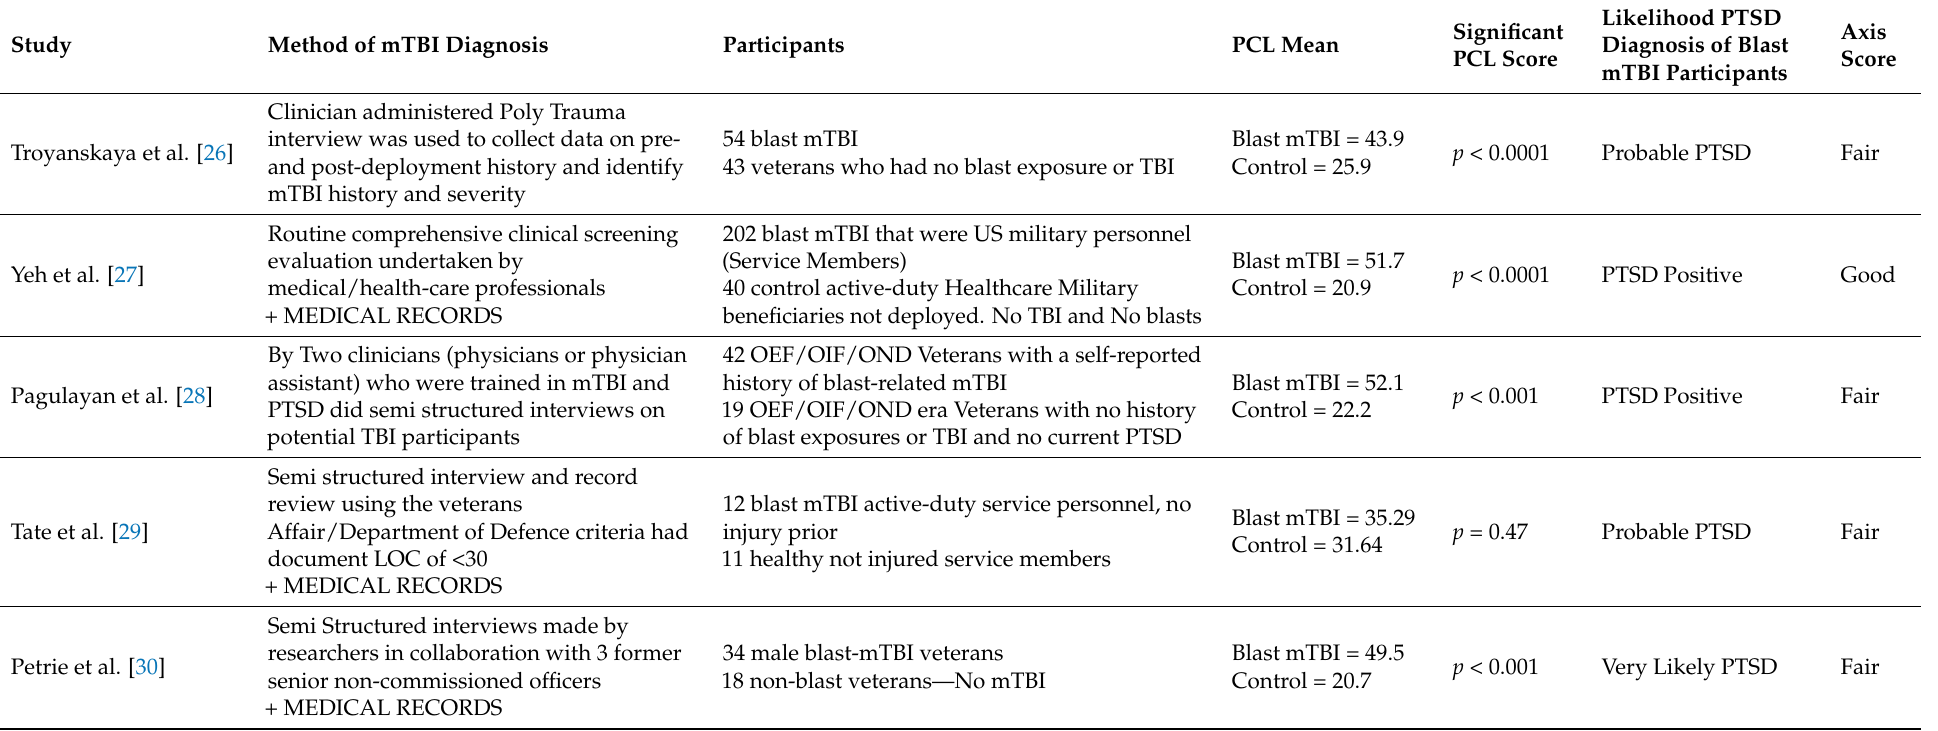
Table 1. Summary of participant information and PCL scores of each paper and PTSD and quality assessment